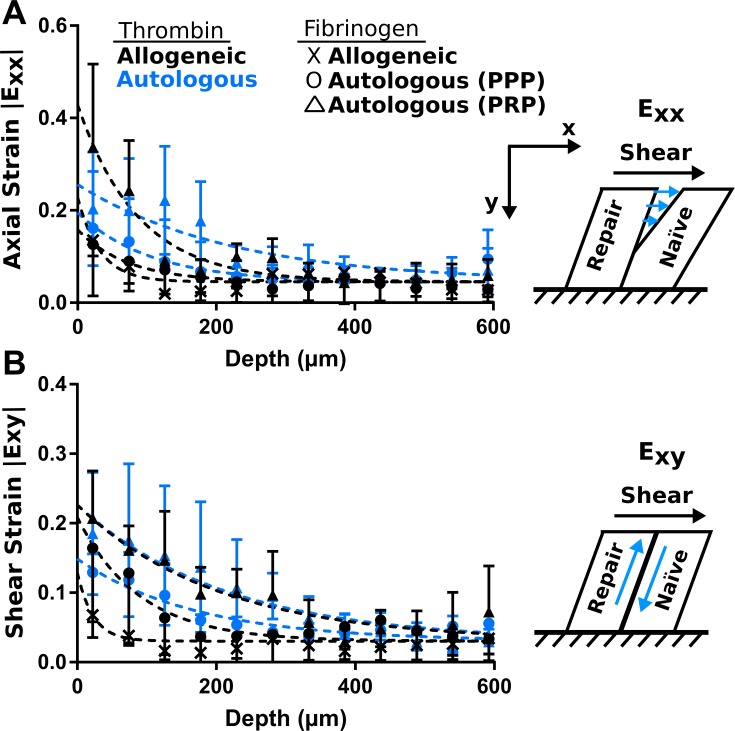
Strains are highest at construct surface and similar between sealants.Axial strains (a) and shear strains (b) are highest at construct surface and decrease with depth. Higher strains indicate pulling apart (axial, Exx) or sliding (shear, Exy) at the interface. Averages of individual samples plotted ± standard deviations (n = 2–4 per sealant). Exponential fits shown by dashed lines for strain averages. Strains are unitless.